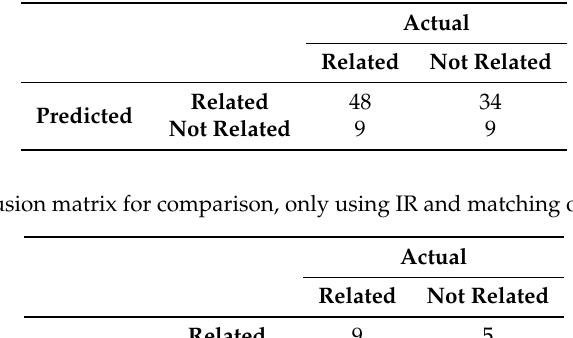
Table 10. Confusion matrix for test data.